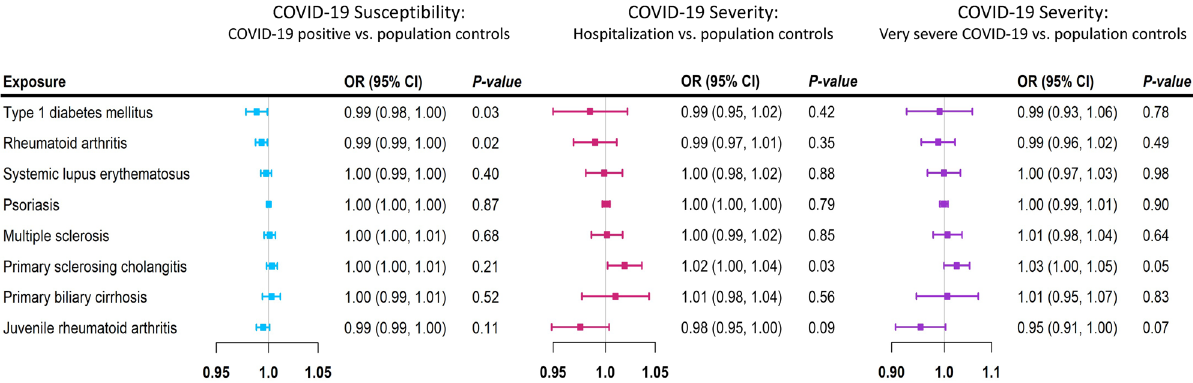
Figure 1. Mendelian randomization (MR) estimates for each autoimmune diseases and COVID-19. Forest plot of MR estimates of 8 autoimmune diseases with COVID-19 infection, hospitalized COVID-19 and very severe COVID-19 using the multiplicative random-effects inverse variance weighting method. The black color represents COVID-19 infection, the blue color represents hospitalized COVID-19 and the red color represents very severe COVID-19. MR estimates are reported as odds ratios per unit of log-odds of each autoimmune disease